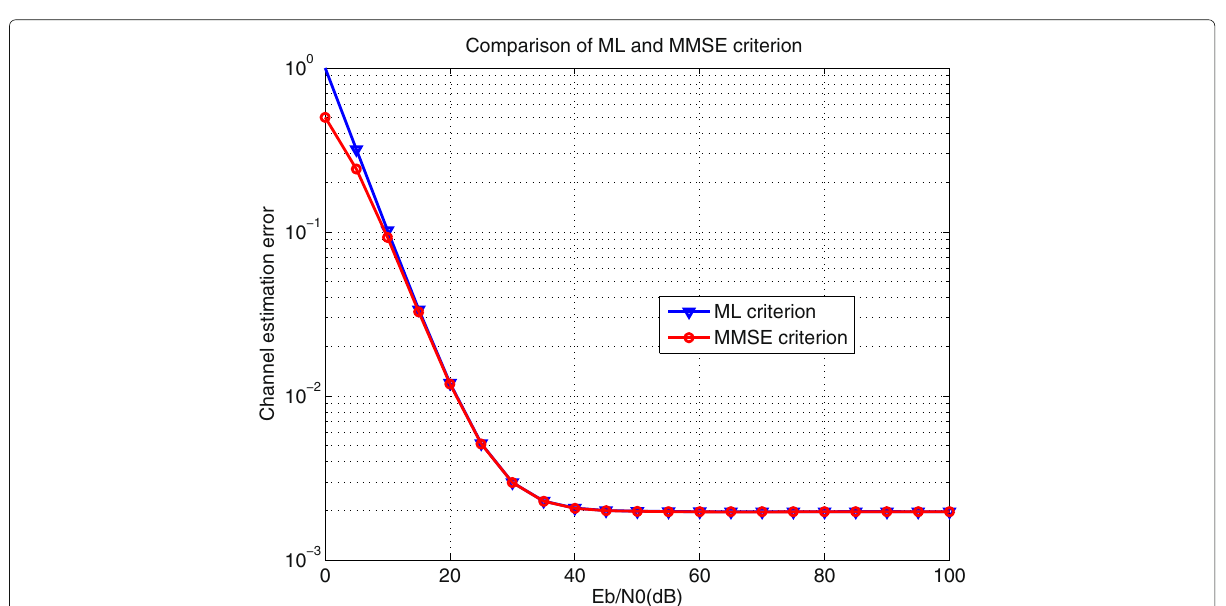
Fig. 2 Comparison of ML and MMSE criterion with f D T s =